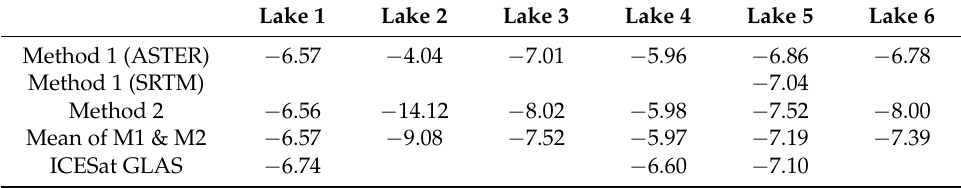
Figure 12. Lake volume (10 9 m 3 = 1 km 3 ), 1998–2017. Total of Lakes 1–6 shown in black. Table 5. Observed rates of change in water level (mm/day) from 2003–2009.